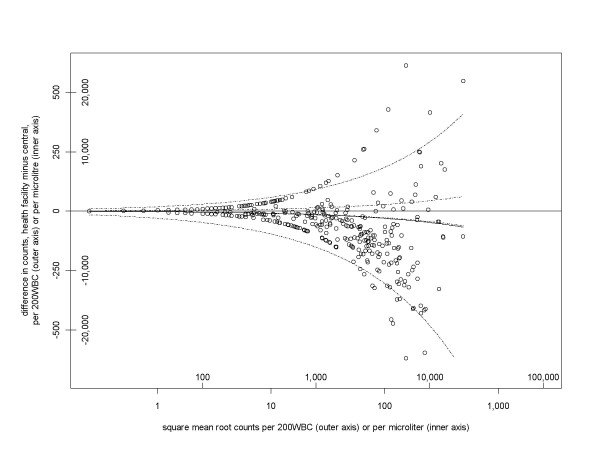
Between-reader variation for trial of training methods[30]. The axes are as in Figure 2. The 95% range of difference in square roots for the 528 pairs is -15.2 to +9.2, which transform to the outer pair of curved dashed lines. The inner pair of dashed lines is the lower limit on this 95% range (-1.39 to +1.39), derived from the Poisson distribution.